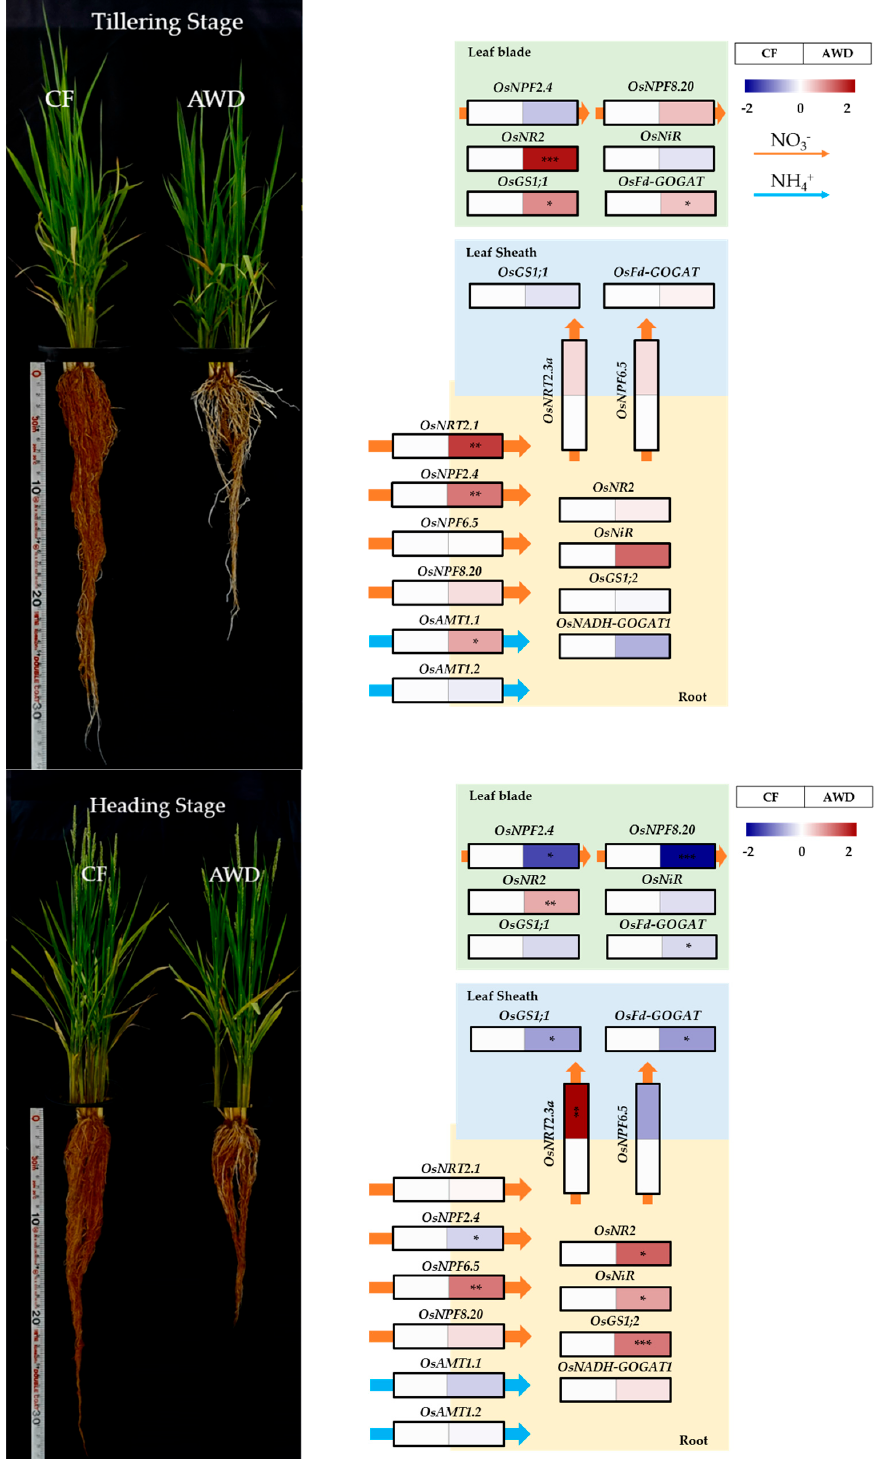
Figure 1. Rice ( O. sativa cv. Jinbongbyeo) growth at both tillering and heading stages. The expression of genes (relative level of AWD to CF) involved in nitrogen metabolism in leaf blade, leaf sheath, and root at both tillering and heading stages subjected to different water managements; CF, continuous flooding; AWD, alternative wetting and drying (n = 3). The colors red and blue represent positive and negative expressions of genes, respectively. The qRT − PCR data was subjected to a t -test. *, **, and *** indicate the significance at p < 0.05, 0.01, and 0.001,